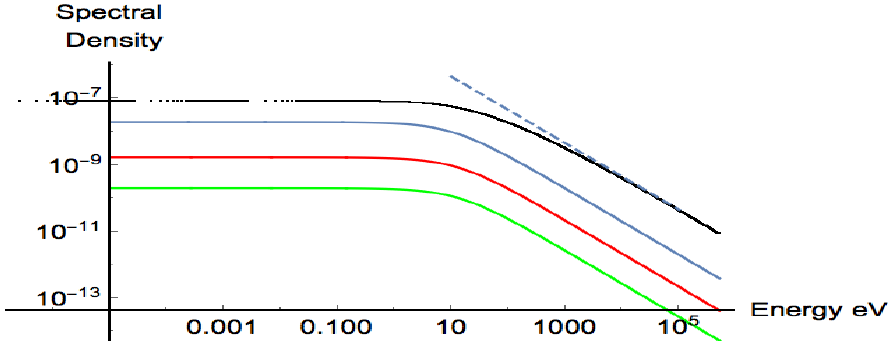
Figure 5. Log-log plot of the 1S spectral density from group theory Equation (29) in black, and the contributions to this shift in the Bethe formalism for the transition 1 S → 2 P (blue), 1 S → 4 P (red), 1 S → 8 P (green). The dashed blue line shows the high-frequency 1/ E asymptote. The black line is the complete spectral density which is the summation of the contributions from all transitions.